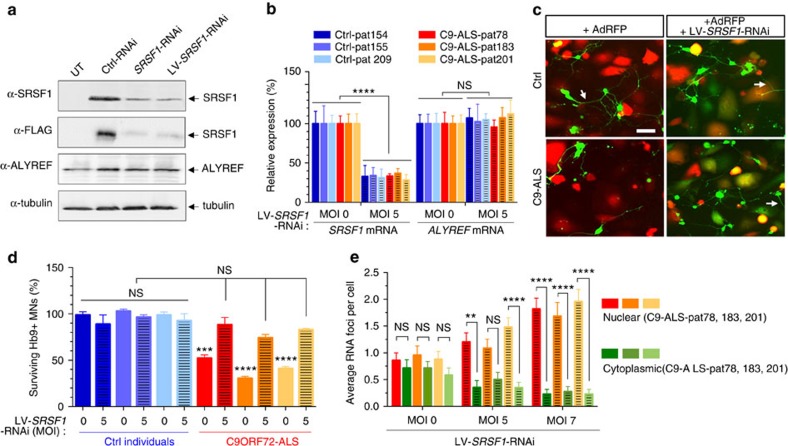
Depletion of SRSF1 suppresses patient-derived C9ORF72-mediated astrocytic toxicity and motor neuron death.(a) Untransfected HEK293T (UT), control (Ctrl)-RNAi, SRSF1-RNAi or LV-SRSF1-RNAi and FLAG-tagged SRSF1 transfected cells were analysed 72 h post-transfection by immunoblotting using anti-FLAG, anti-ALYREF and loading control anti-α-Tubulin antibodies. (b) SRSF1 and ALYREF transcript levels were quantified by qRT–PCR analysis following normalization to U1 snRNA levels in three biological replicate experiments (mean±s.e.m.; two-way ANOVA with Tukey’s correction for multiple comparisons; N (qRT–PCR reactions)=6). Three control (Ctrl-pat) and three C9ORF72-ALS (C9-ALS-pat) colour-coded patient lines were used. (c) Representative immunofluorescence microscopy images from iAstrocytes and motor neuron co-cultures. iAstrocytes derived from controls (top left image) and C9ORF72-ALS patients (bottom left image) were transduced with Ad-RFP as viral control and cultured with Hb9GFP+ motor neurons (green). C9ORF72-ALS iAstrocytes exhibit toxicity against motor neurons as previously reported. Transduction of control Ad-RFP iAstrocytes with LV-SRSF1-RNAi co-expressing GFP led to consistent survival of Hb9GFP motor neurons on control astrocytes (top right image) and increase in survival of motor neurons on C9ORF72-ALS astrocytes (bottom right image). Arrows point to examples of axons of motor neurons. Scale bar, 50 μm. (d) Same control (Ctrl-pat) and C9ORF72-ALS (C9-ALS-pat) colour-coded patient lines (as in b) are used for quantification of Hb9-GFP+ motor neuron counts in four biological replicates of co-cultures of astrocytes and motor neurons at day 3 (mean±s.e.m.; one-way ANOVA with Tukey’s correction for multiple comparisons; N (Hb9-MNs)=Ctrl-pat154: 567/589/582/500, Ctrl-pat154+SRSF1-RNAi: 620/543/504/349, Ctrl-pat155: 602/610/553/571, Ctrl-pat155+SRSF1-RNAi: 554/584/532/516, Ctrl-pat209: 519/599/584/535, Ctrl-pat209+SRSF1-RNAi: 617/486/425/572, C9-ALS-pat78: 352/279/294/258, C9-ALS-pat78+SRSF1-RNAi: 569/451/398/583, C9-ALS-pat183: 200/188/154/145, C9-ALS-pat183+SRSF1-RNAi: 480/420/380/399, C9-ALS-pat201: 201/243/261/224, C9-ALS-pat201+SRSF1-RNAi: 486/463/444/485). (e) Quantification of nuclear and cytoplasmic sense RNA foci in SRSF1-RNAi-transduced iAstrocytes (mean±s.e.m.; two-way ANOVA; N (cells with 1-5 RNA foci)=C9-ALS-pat78+MOI0: 21, C9-ALS-pat78+MOI5: 20, C9-ALS-pat78+MOI7: 22, C9-ALS-pat183+MOI0: 21, C9-ALS-pat183+MOI5: 24, C9-ALS-pat183+MOI7: 22, C9-ALS-pat201+MOI0: 24, C9-ALS-pat201+MOI5: 23, C9-ALS-pat201+MOI7: 22). >95% of cells with RNA foci presented a total of 5 or fewer foci. Statistical significance of data is indicated as follows: NS: non-significant, P≥0.05; *P<0.05; **P<0.01; ***P<0.001; ****P<0.0001.